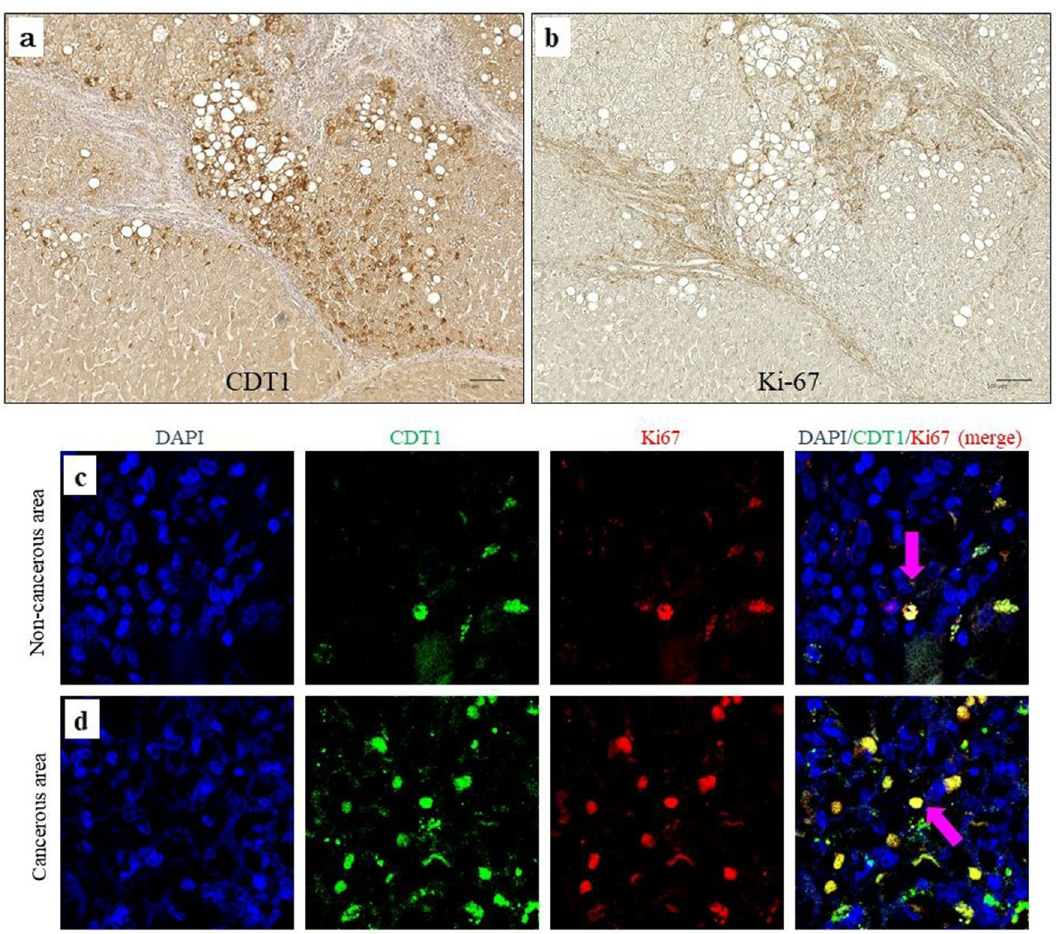
Figure 6. Comparison of Immunohistochemistry images of CDT1-positive and Ki-67-positive hepatocytes in lobules in continuous noncancerous formalin-fixed paraffin-embedded (FFPE) noncancerous liver sections in Cohort 4. ( a ) Localization of CDT1-positive cells in lobules (counterstained with hematoxylin, × 100). ( b ) Localization of Ki-67-positive cells in lobules (counterstained with hematoxylin, × 100). ( c ) Representative immunofluorescence images of CDT1, Ki-67 and Prolong, which contained 4’,6-diamidino-2-phenylindole (DAPI), in noncancerous FFPE liver sections. Blue, nuclei counterstained with Hoechst 33342, green, CDT1, red, Ki-67 and merged image (right). Arrows indicate the colocalization of CDT1 with Ki-67 in the nuclei of hepatocytes. ( d ) Representative immunofluorescence images of CDT1, Ki-67 and DAPI in cancerous FFPE liver sections. Blue, nuclei counterstained with DAPI, green, CDT1, red, Ki-67 and merged image. Arrows indicate the colocalization of CDT1 with Ki-67 in the nuclei of cancer